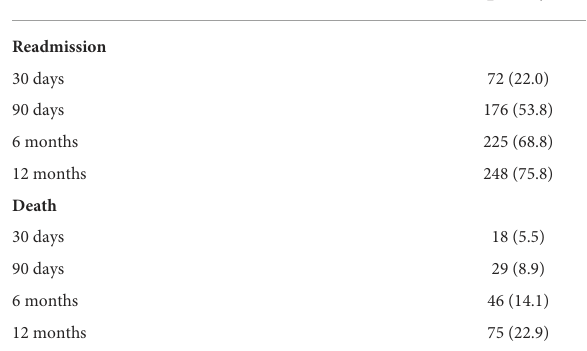
TABLE 5 Readmissions and death.